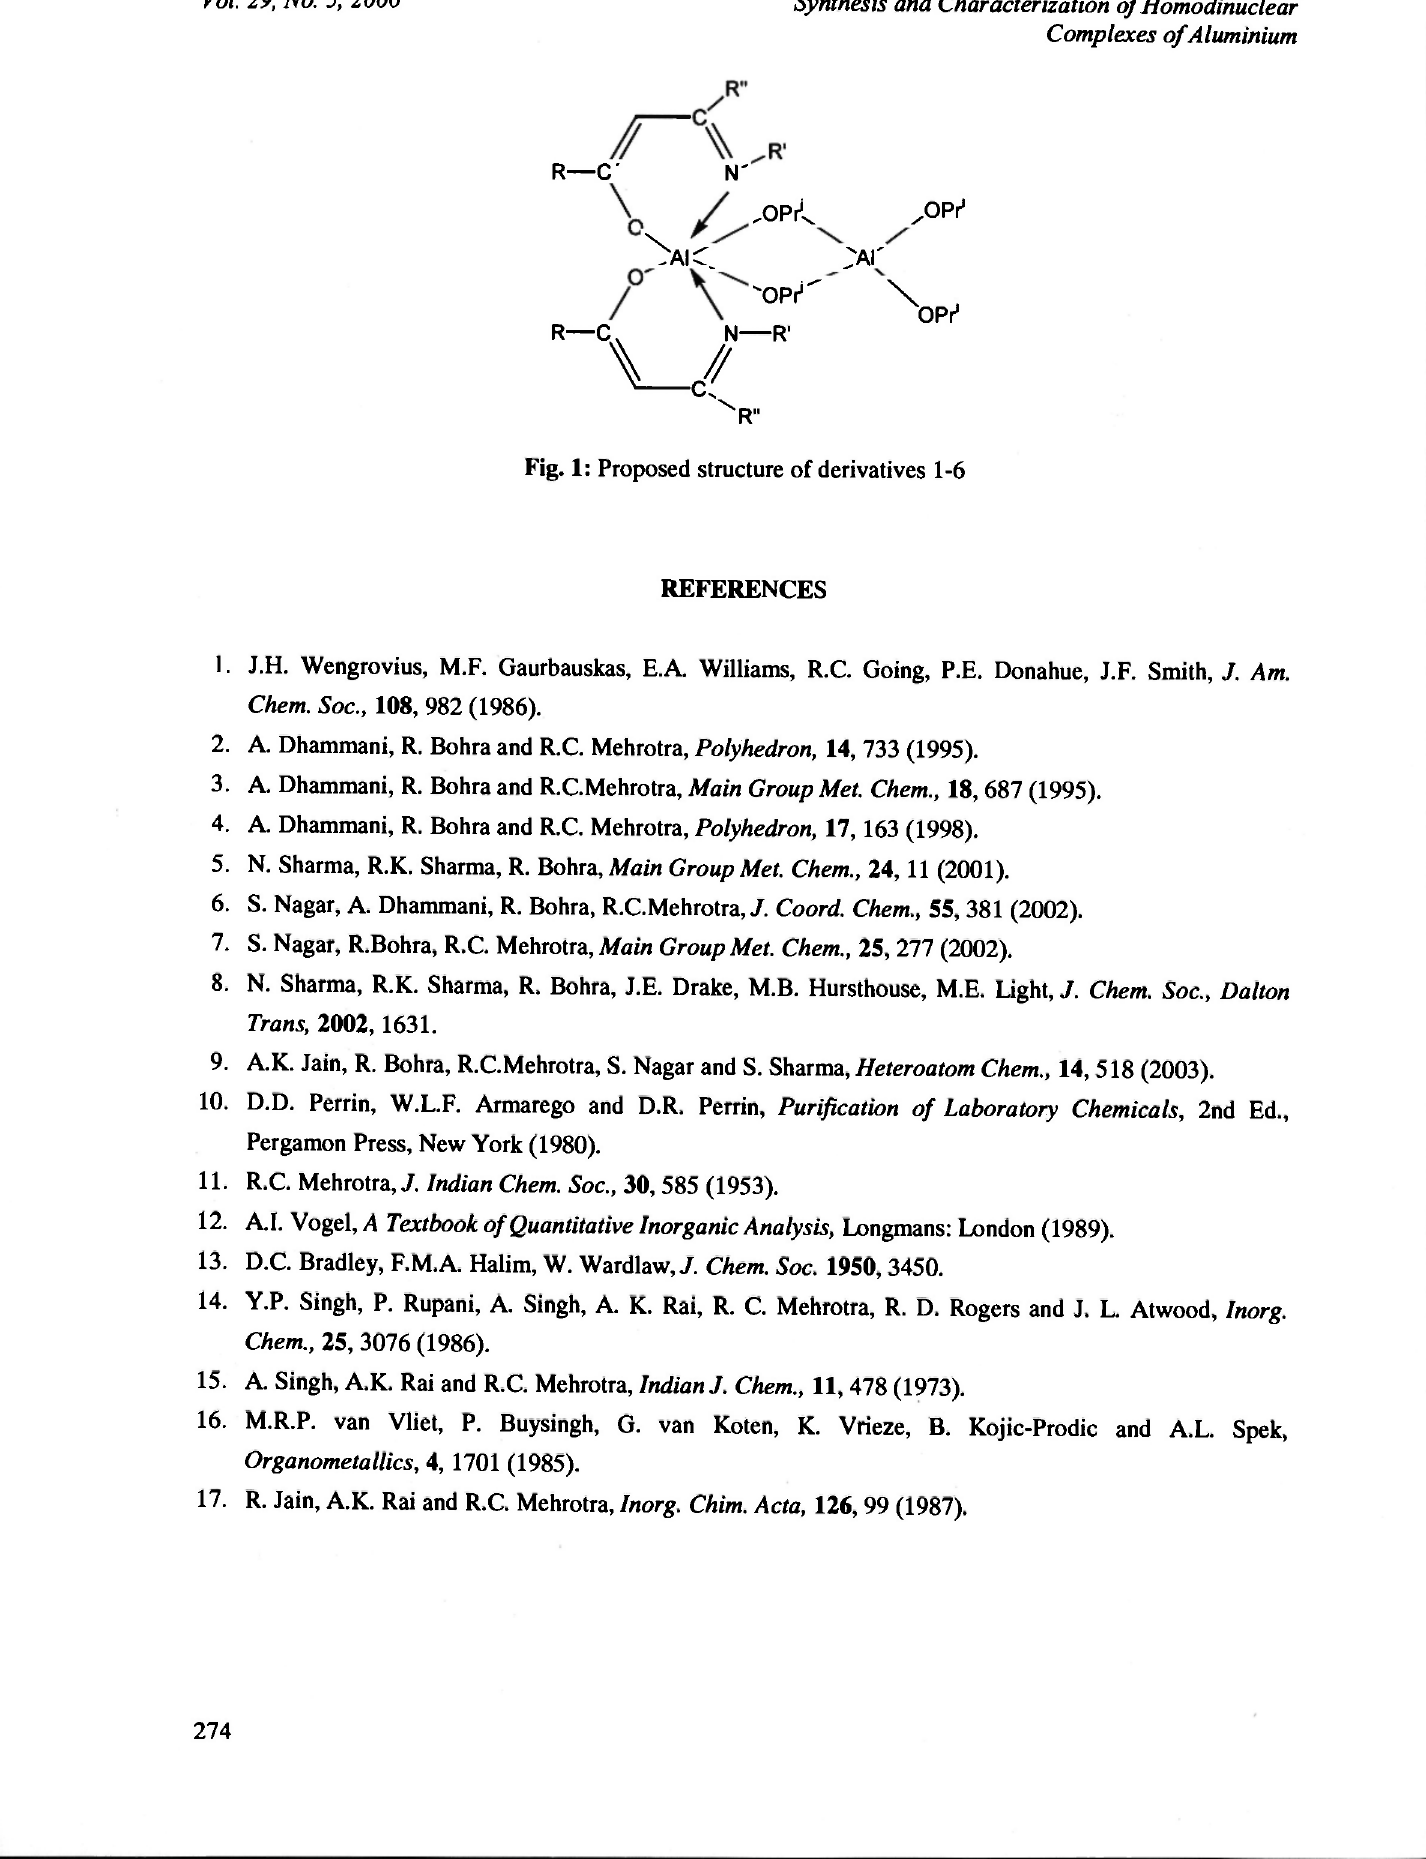
Fig. 1: Proposed structure of derivatives